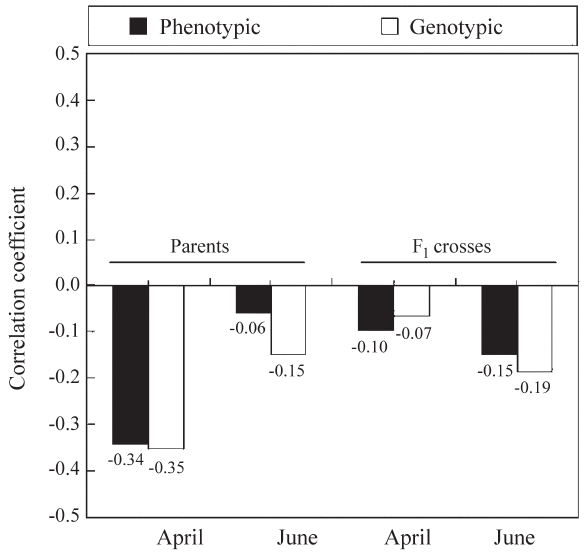
Figure 2 - Phenotypic and genotypic correlation coefficients between rel- ativecellinjuryandheattoleranceindexinuplandcottoncultivarsandhy- brids under heat stressed and non-stressed field